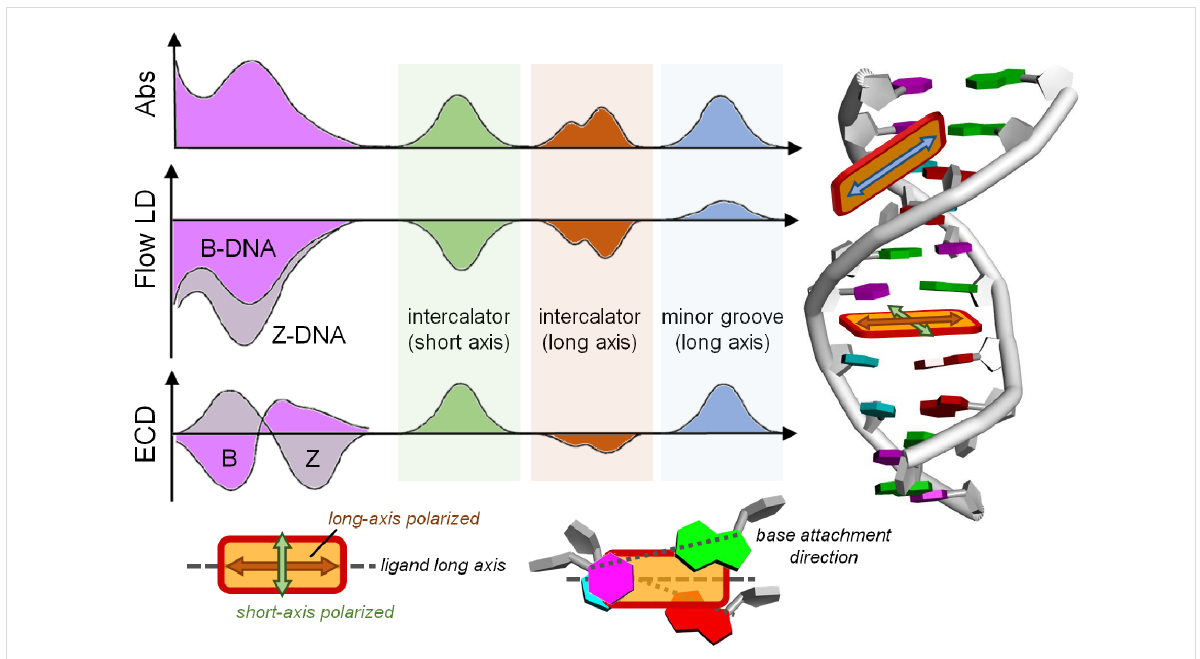
Figure 7: Empirical analysis of ECD and flow LD spectra to establish the preferred orientation of a ligand bound to DNA. We define the transition moment of the ligand oriented “parallel” to the long axis of adjacent base pairs, when it is halfway between the closest base attachment directions (bottom right panel). The LD is sensitive to the arrangement of the dye transition moment with respect to the helix axis, and to the overall orientation of the DNA double helix with respect to the flow direction (see Figure 9, below); Z-DNA is easier to orient than B-DNA because of a more extended elongation. ECD in the region <300 nm reflects the DNA conformation, in particular the mutual arrangement between nucleobases, which is different for right-handed B and left-handed Z-DNA. In the region >300 nm, the ligand ICD depends on the arrangement of the ligand chromophore with respect to the nucleobases. The sign of ICD is opposite for mutually orthogonal transition moments (long vs short axis) allied with an intercalated